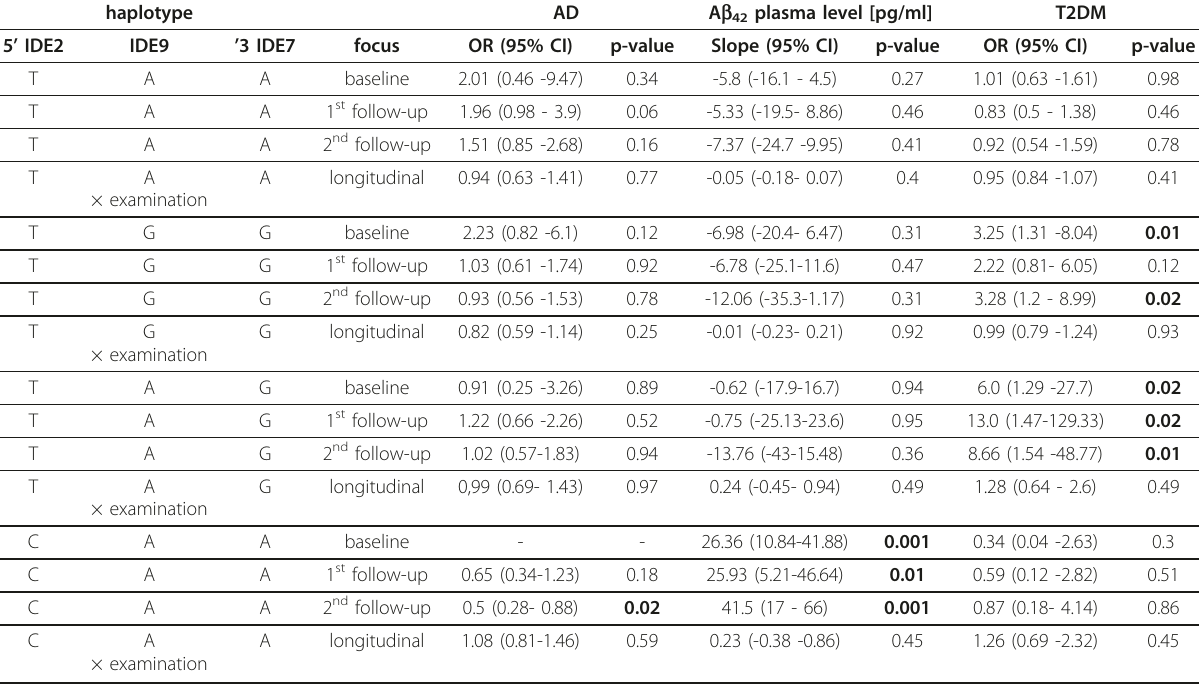
Table 2 Association results of insulin degrading enzyme haplotypes haplotype